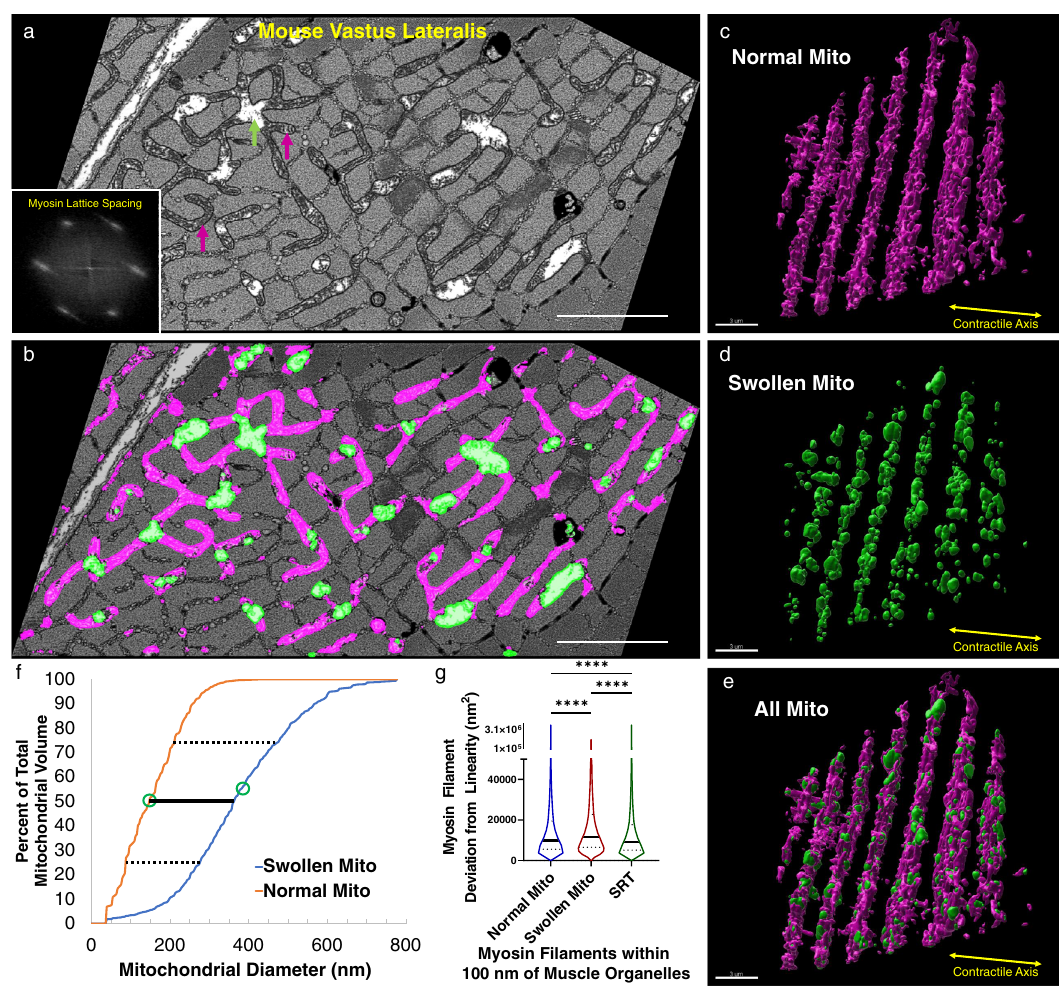
Fig. 6 | Acute, localized mitochondrial swelling increases the curvature of nearby myosin fi laments. a Raw 2D FIB-SEM image of mouse vastus lateralis muscle with fi xation induced swelling within several regions of the mitochondrial network. Green arrows: swollen mitochondria. Magenta arrows: normal mito- chondria.Inset,averagefastfouriertransformimageofrawFIB-SEMdataacrossan entire single sarcomere showing hexagonal myosin lattice spacing. b Raw image fromaoverlaidwithmachinelearningsegmentationresultsforswollen(green)and normal (magenta)mitochondria. Scalebar:1 µ m ( c – e ) 3D renderings of normal( c ), swollen ( d ), and all ( e ) mitochondria within a mouse vastus lateralis muscle. f Mitochondrial diameters for swollen (orange line) and normal (blue line)